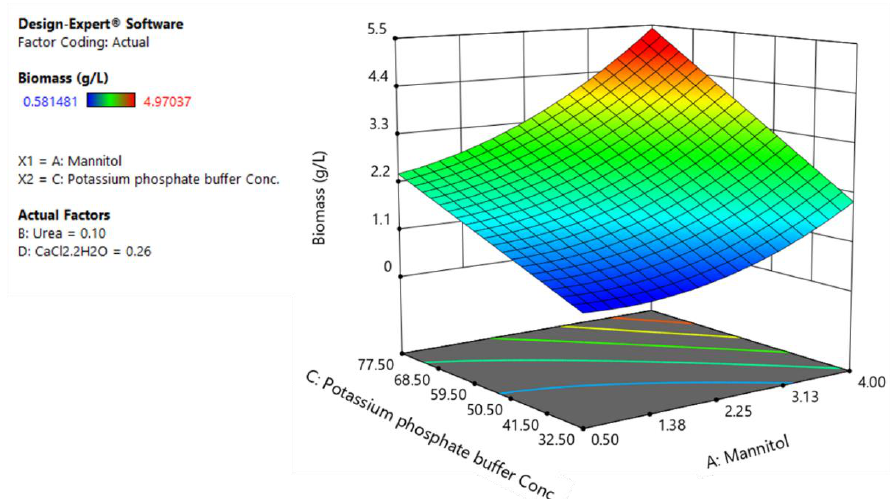
Figure 5. The response surface plot of biomass production as a function of potassium phosphate buffer and mannitol.